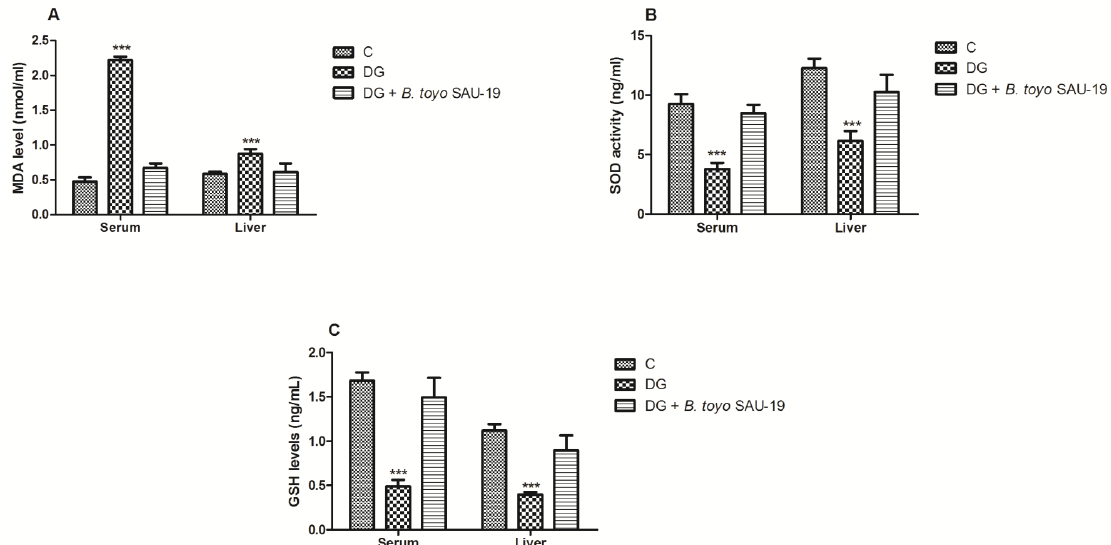
Figure 5. Effects of Bacillus toyonensis SAU-19 on antioxidant activity in HFD/STZ-induced T2DM mice. ( A ) Levels of MDA in blood and liver serum (nmol/L). ( B ) Levels of SOD in blood and liver serum (ng/mL). ( C ) Levels of GSH in blood and liver serum (ng/mL). Values are shown as mean ± Sd. Bars with *** are statistically different ( p < 0.05), DG compared with the control (C) and B. toyo SAU-19 groups ( n = 6). MDA — malondialdehyde, SOD — superoxide dismutase, GSH — gluta- thione.